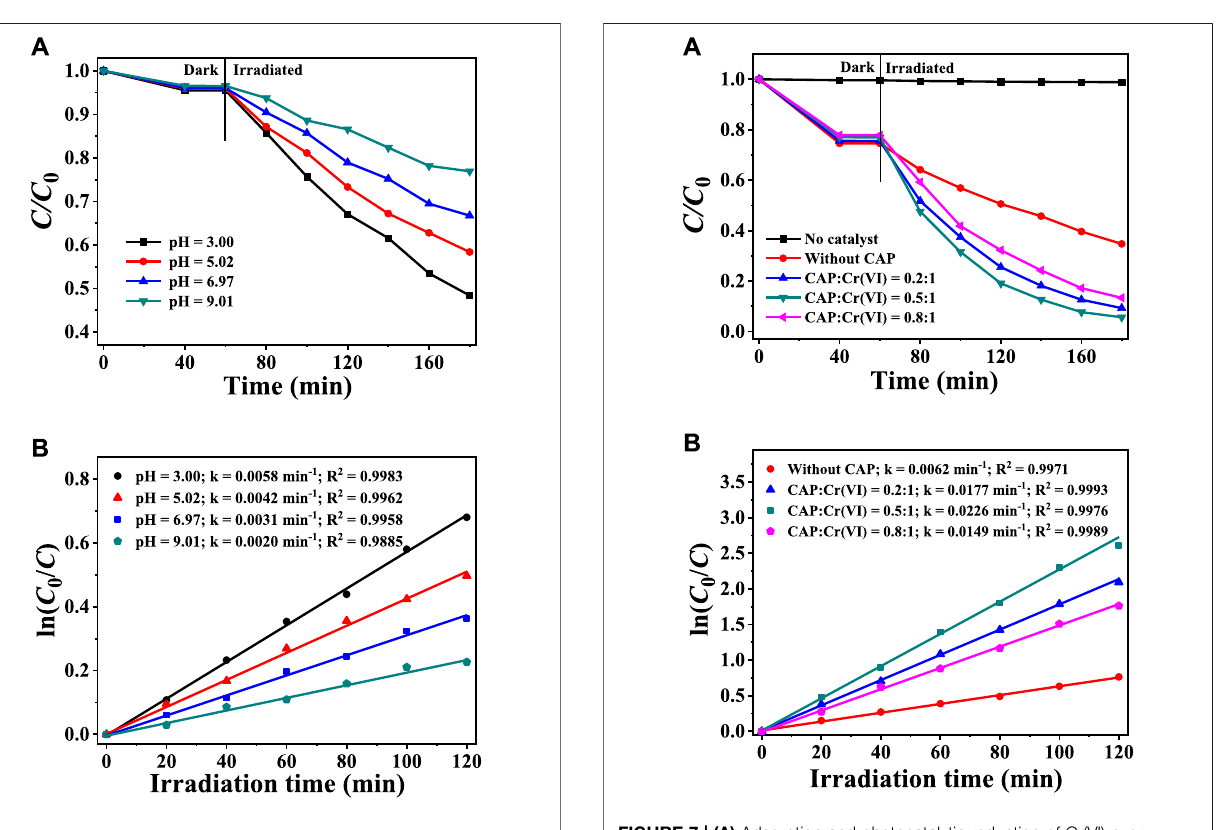
FIGURE 6 | (A) Adsorption and photocatalytic degradation of CAP over CuInS 2 in the mixed solution of CAP and Cr(VI) at different pH conditions (B) Corresponding kinetics plots for the photocatalytic CAP degradation reactions in (A) . ([Cr(VI)] = 10 mg/L, [CAP] = 10 mg/L, [catalyst] = 0.2 g/L).